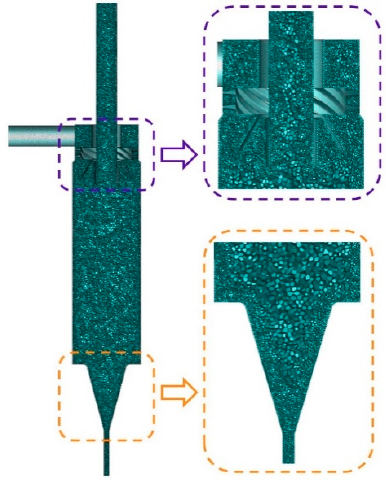
Figure 5. Grid division of the cyclone separator.